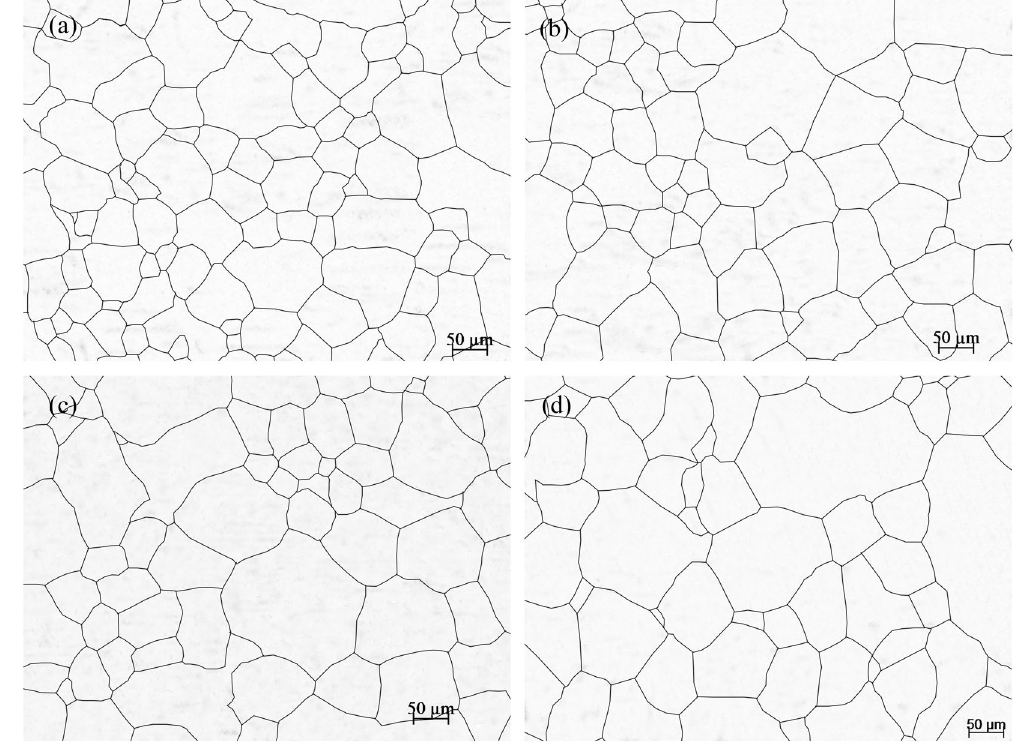
Figure 5. The effects of the holding time on the grain growth at 1050 °C. ( a ) 10 min; ( b ) 40 min; ( c ) 120 min; and ( d ) 180 min.